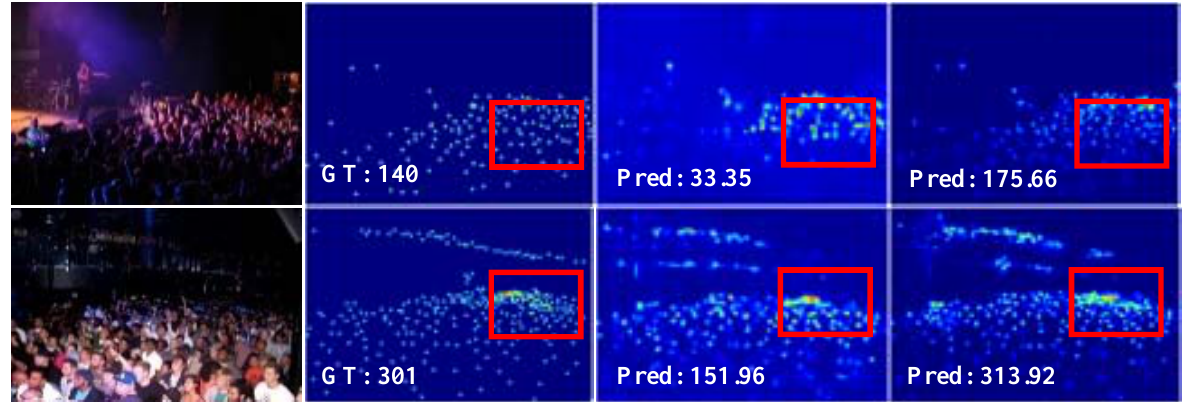
Figure 1. Representative examples in the UCF-QNRF dataset [17]. From left to right: input images, ground-truth, results of CSRNet [8], and the results of MSCANet. Compared to CSRNet, MSCANet can effectively handle the ambiguity of appearance between crowd and background